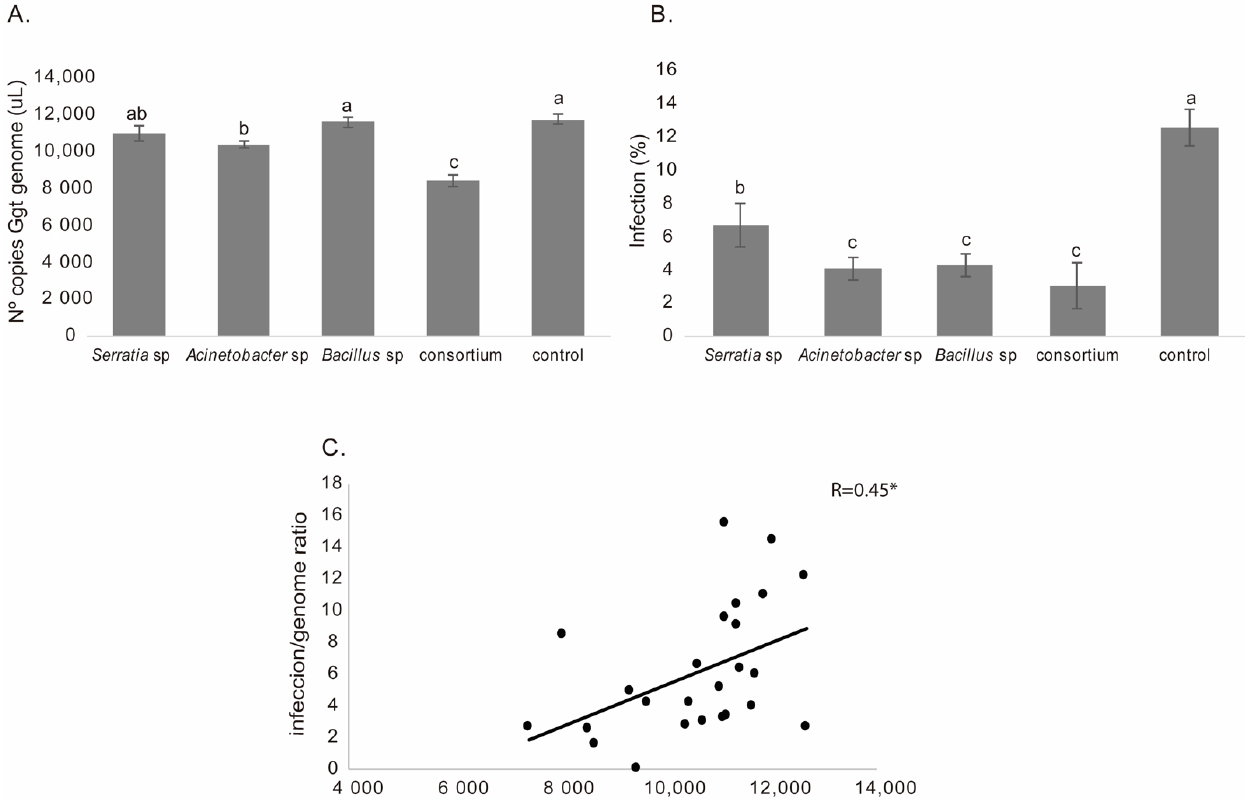
Figure 2. ( A ) Detection and quantification of the number of Ggt genome copies in infected roots 40 days after inoculation with 1% of Ggt; ( B ) infection measured by blackening of roots 40 days after inoculation with 1% of Ggt; and ( C ) relationship between Ggt genome copies (quantified in real time using the specific primer set GGT2F/GGT168R) and blackening of roots 40 days after inoculation with 1% of Ggt. Tukey’s test was used to compare treatment means; values followed by the same letter did not differ at p < 0.05 ( n = 5). * Denotes significant differences at p<0.05.